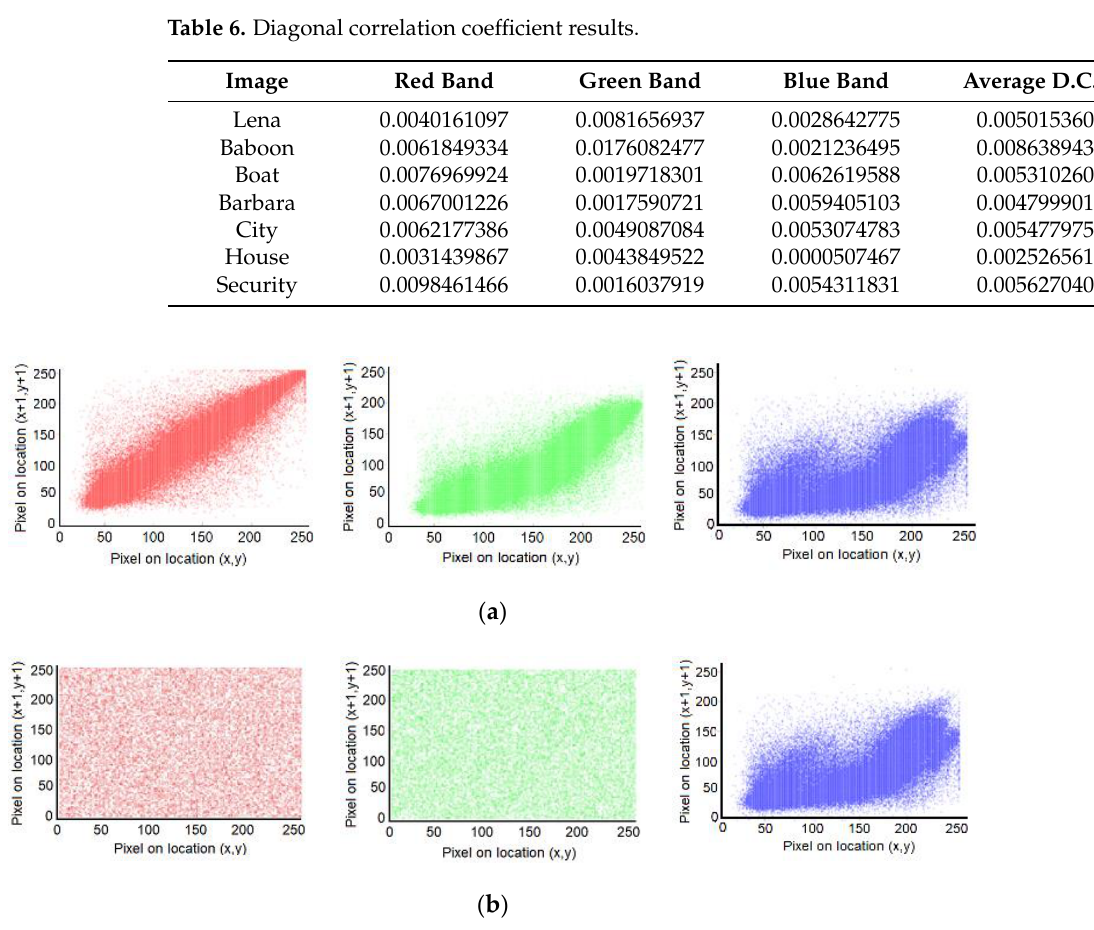
Table 6. Diagonal correlation coefficient results.